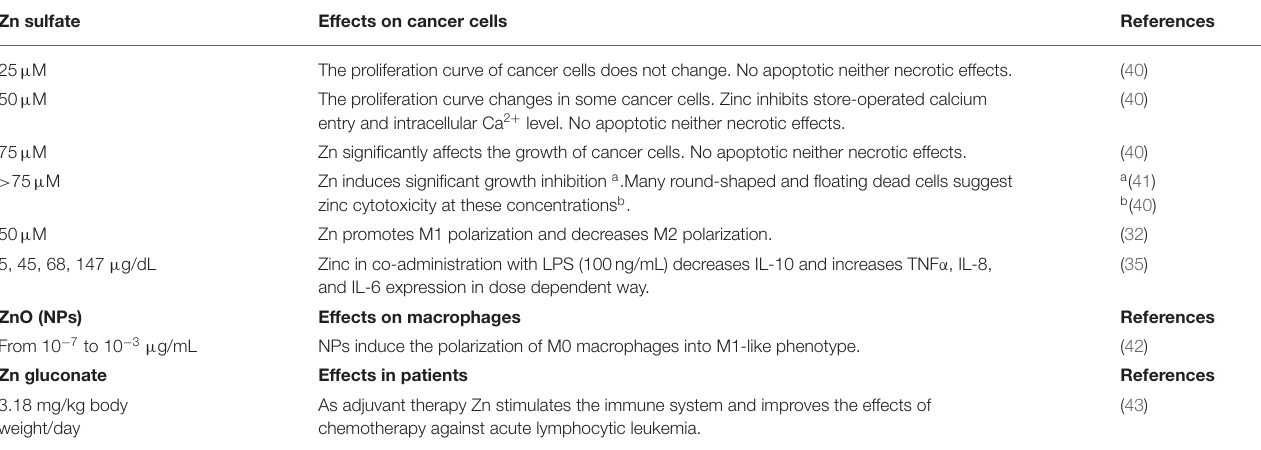
TABLE 1 | Effects of Zinc on cancer cells and macrophages at different concentrations. Zn sulfate Effects on cancer